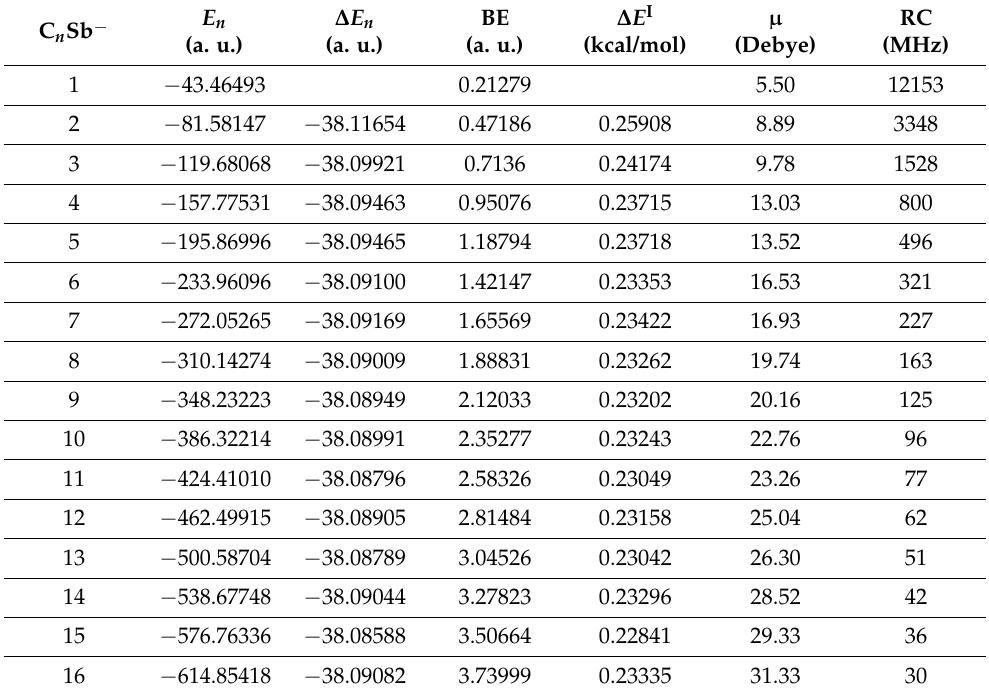
Table 6. The total energies E n , differential energies ∆ E n , incremental energies ∆ E I , binding energies BE, dipole moments ( µ ), and rotational constants (RC) of C n Sb-